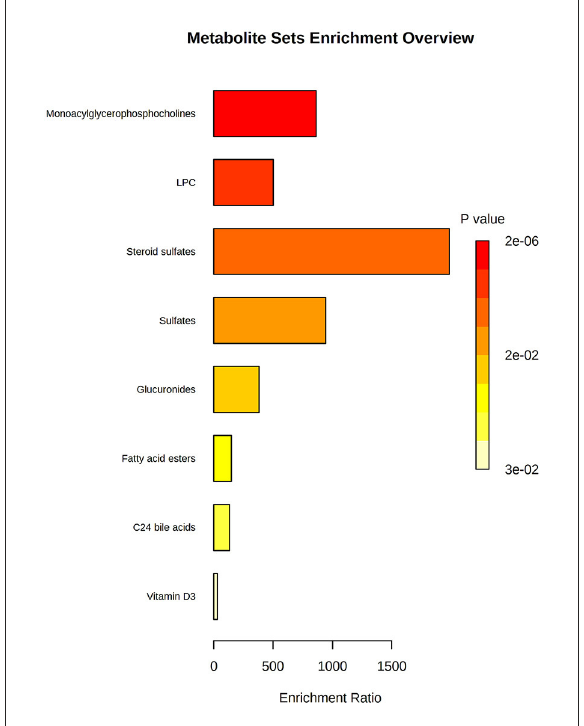
FIGURE5 Enrichment analysis of the most changed biological categories for the altered compounds. P- value is shown by a yellow-red color scale; and the relevance of the change is shown by an enrichment